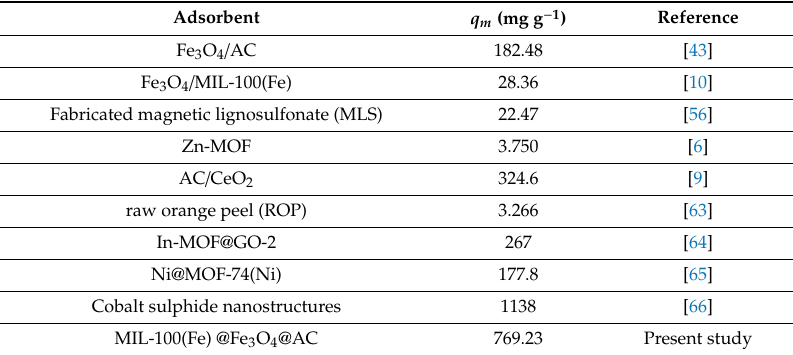
Table 3. The q m values for the adsorption of RhB on di ff erent